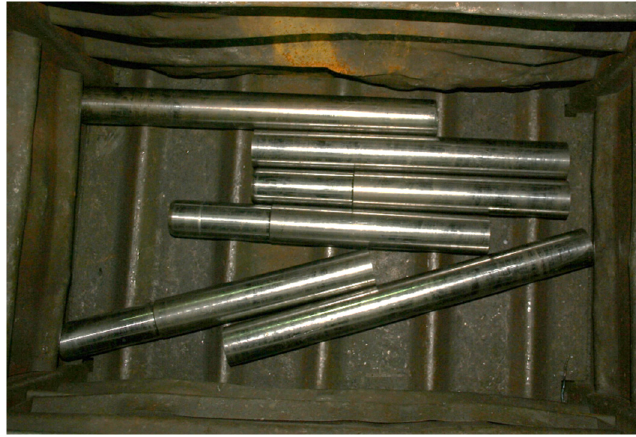
Figure 6. 30MnB5 bars employed for the study.